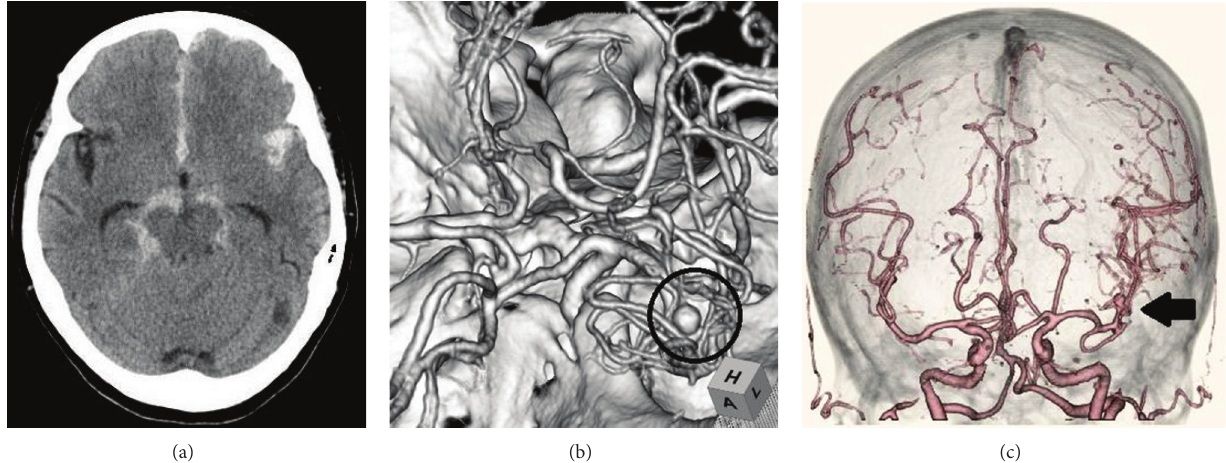
Figure 2: A subarachnoid hemorrhage (a) originating from the cerebral aneurysm on the left middle cerebral artery (b, c).